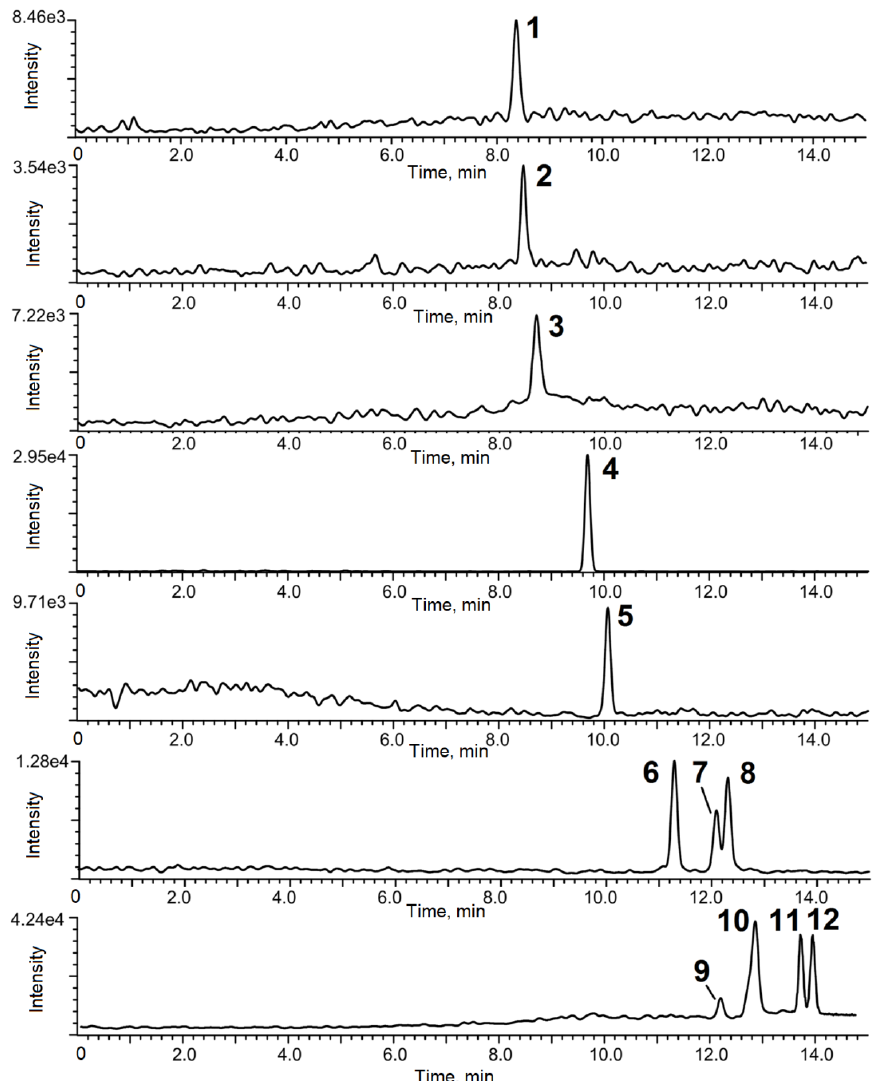
Figure 2. Chromatogram of metabolite standards (1 ng / mL, except for IS at 10 ng / mL). 1—salicylic acid, 2—phenylsuccinic acid, 3—benzoic acid, 4—4-fluorobenroic acid C13-D' (IS), 5—benzylsuccinic acid, 6— o -toluic acid, 7— m -toluic acid, 8— p -toluic acid, 9—2-(1-phenylethyl)-succinic